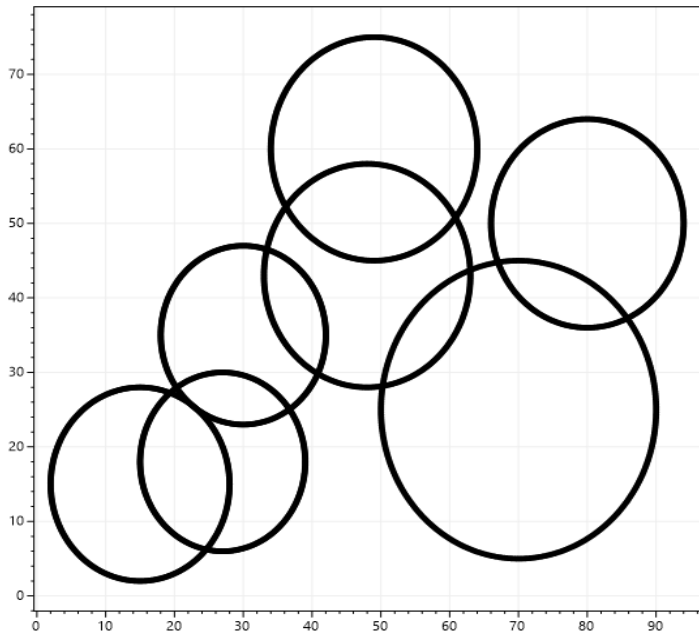
Figure 1. Input network.